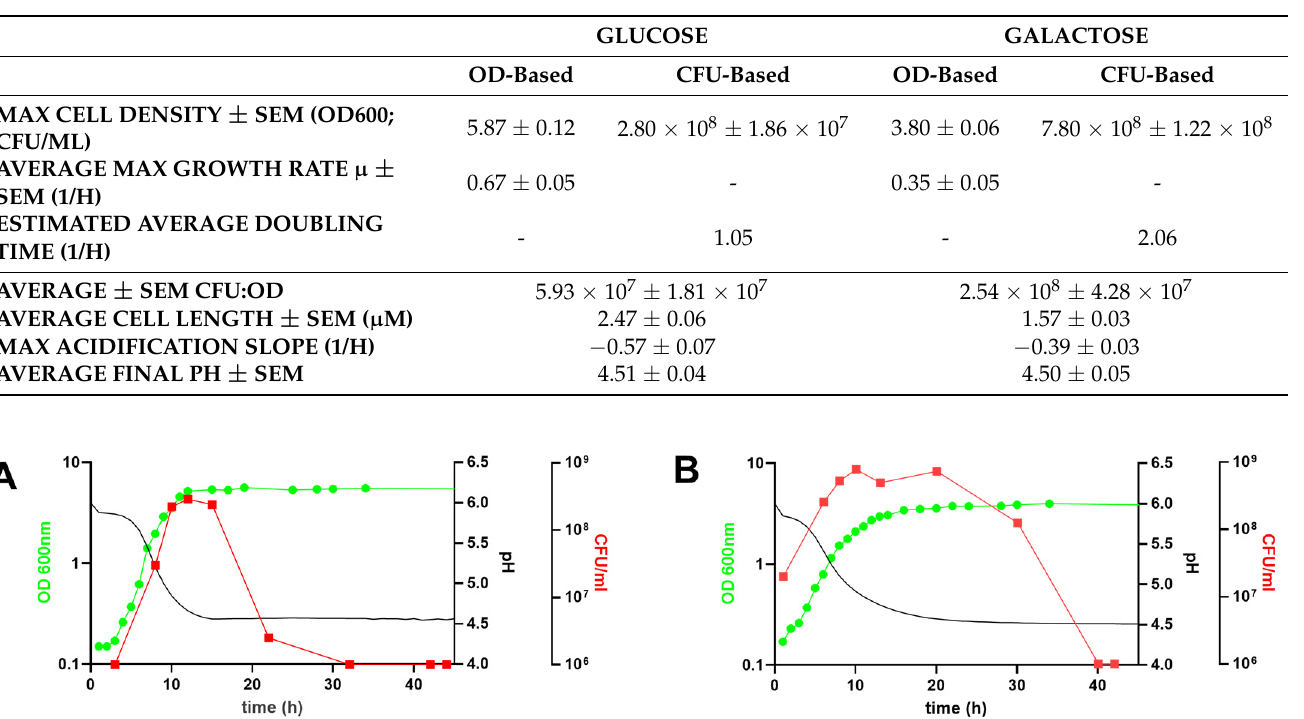
Figure 2. Confocal microscopic pictures of cells of B. longum NCC 2705 grown in DasGip bioreactors with 1% of glucose ( A ) or 1% of galactose ( B ). Panel C shows the cell size of both cultures (galactose in red, glucose in grey) represented by the forward scatter signal obtained by flow cytometry. Sta- tistical analyses were performed using Welch- t test (**** p < 0.0001) on modeled population distri- butions. 3.2. Glucose or Galactose Dependent Central Carbon Metabolism Fluxes Modifications An initial gene ontology (GO) enrichment analysis revealed a particular enrichment in genes related to the carbohydrate metabolism (Figure S1; Tables S1 and S2), which trig- gered us to analyze the transcription of the genes related to the carbon import and metab- olism (bifid-shunt). It revealed that growth on glucose induced the expression of glucose import systems ( Bl1631 (MFS) and BL1633 (part of PTS)), enzymes involved in glucose-6- phosphate conversion ( BL1631 ; 6PGL ), pyruvate and acetate formation ( BL0707 ( pgk ) and BL112 4 ( aldH )), the galE1 gene ( BL1644 ) encoding the conversion of UDP-glucose to UDP- galactose, as well as the ATP binding function ( BL1692 ) of the ABC transport system that was previously annotated to import arabinose [44] (Figure 3). In contrast, growth on ga- lactose induced the expression of a substantially larger number of functions, including the relatively high-level induction of carbohydrate transporters (ABC ( BL0189 ) and an MFS transport system ( BL0165 ), upregulated 3.0 and 3.5 fold, respectively) that we propose to be involved in galactose import. Furthermore, functions related to the catabolism of the imported galactose were upregulated, including the conversion of D-galactose to D-glu- cose-6-phosphate and D-fructose-6-phosphate ( BL0739 ( ugpA ), BL1210 ( galK ), BL1671 ( galE2 ), BL1211 ( galT1 ), BL1643 ( galT2 ), BL1630 ( pgm ) and BL0279 ( pgi )). Notably, two genes ( BL1694 , BL1695 ) that encode an ABC system transporter previously suggested to be involved in arabinose transport [44] were also induced, similarly to araA ( BL0272 ) which encodes the conversion of D-arabinose into D-ribulose, suggesting the activation of other sugar catabolism functions unrelated to galactose. Although the gene encoding F6PPK (fructose-6-phosphate-phosphoketolase, BL0959 ) that plays a central role in the bi- fid-shunt was not differentially expressed, the tpk gene ( BL1364 ), responsible for the pro- duction of thiamin that acts as an essential cofactor for F6PPK, was upregulated. The ac- tivity of the F6PPK enzyme upon growth on galactose could thus be enhanced, which